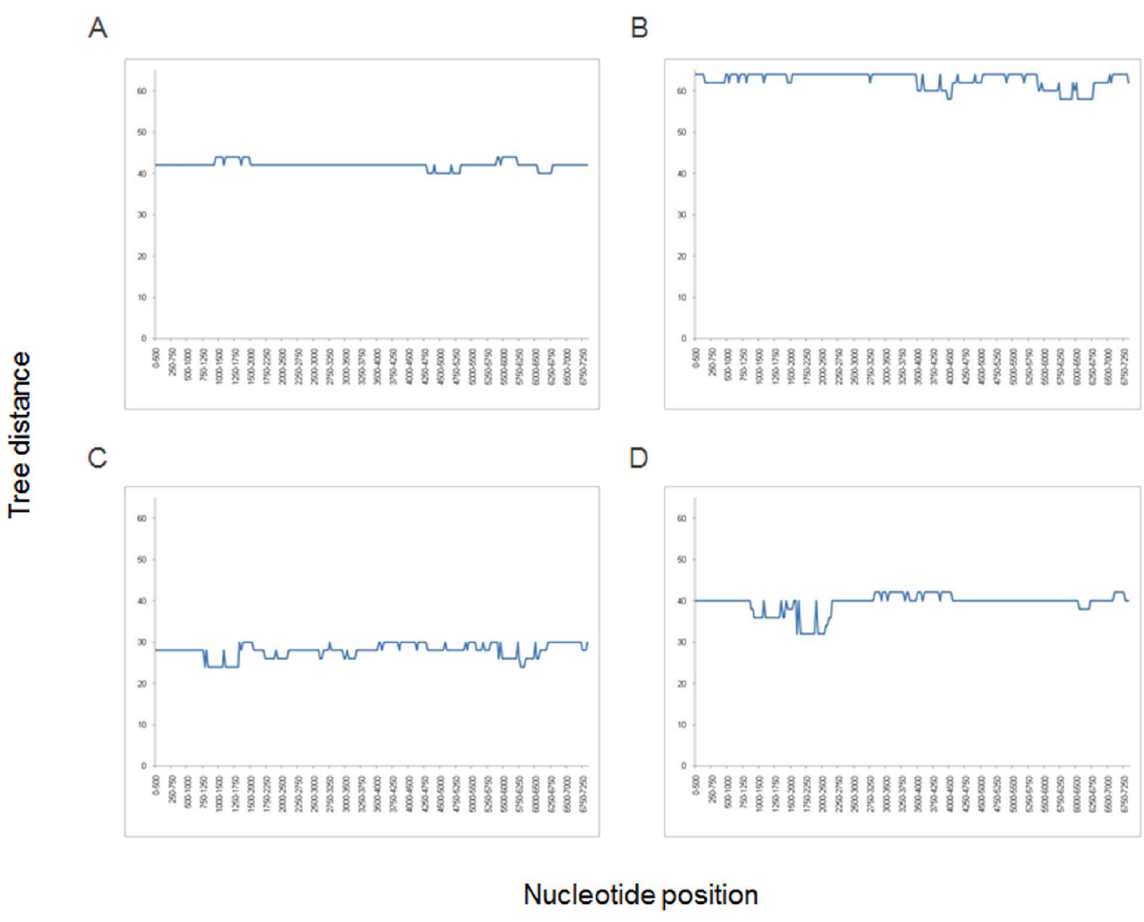
Figure 6. Tree topology analysis. Tree topology analysis using a sliding window (500 nt) approach. Trees constructed for each window were compared to the reference tree containing WG sequences from each outbreak.